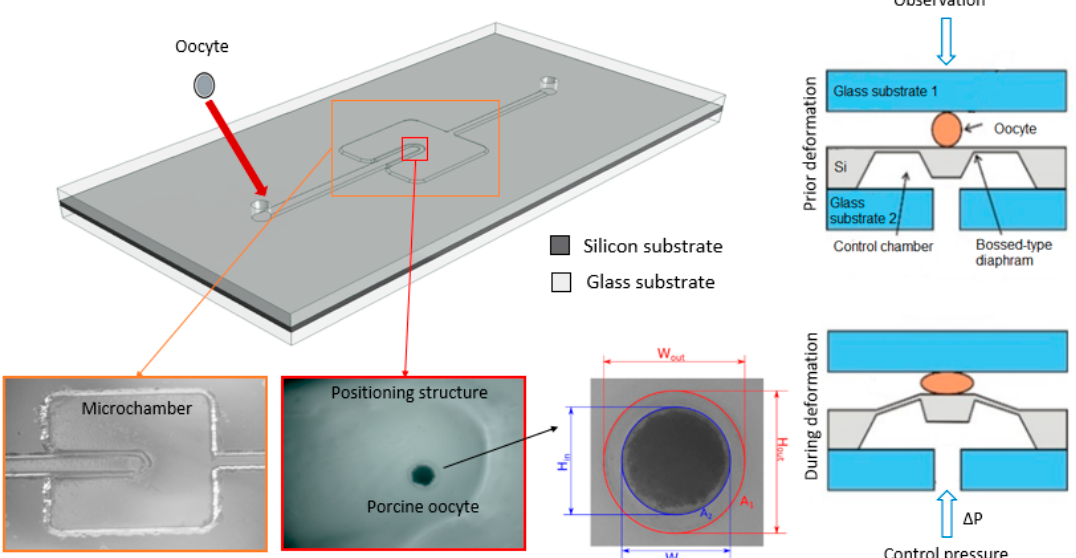
Figure 1. Visualization of the deformation micrometer (view from above) along with microscopic photo of the micromachined trapping structure in the glass, next view of the porcine oocyte in the measurement chamber and cell with the parameters determined by the software analysis (W out , H out , W in , H in , A 1 , A 2 ).